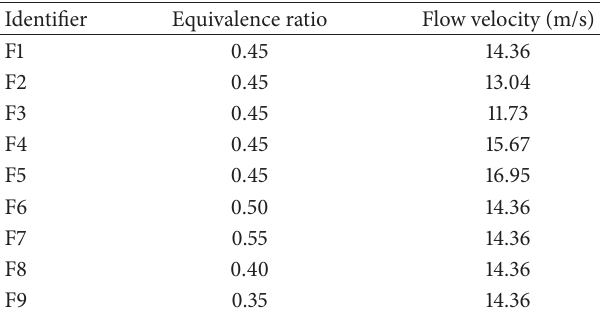
Table 3: A list of 9 flame conditions with different flow velocities and equivalence